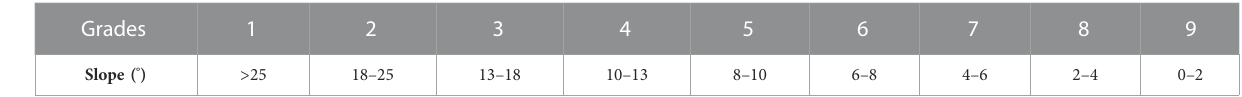
TABLE 4 Slope grade